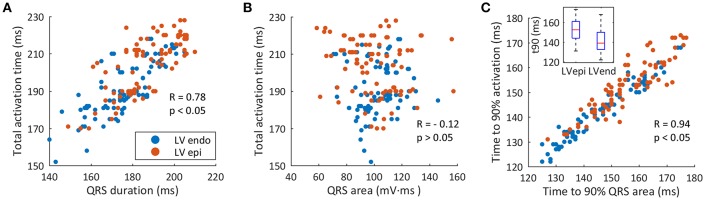
Correlation between ventricular activation and QRS. (A) Correlation between QRS duration and TAT (red circles show LV epicardial leads, blue circles show LV endocardial leads). (B) Correlation between the QRS area and TAT. (C) Correlation between t90QRSa and t90.